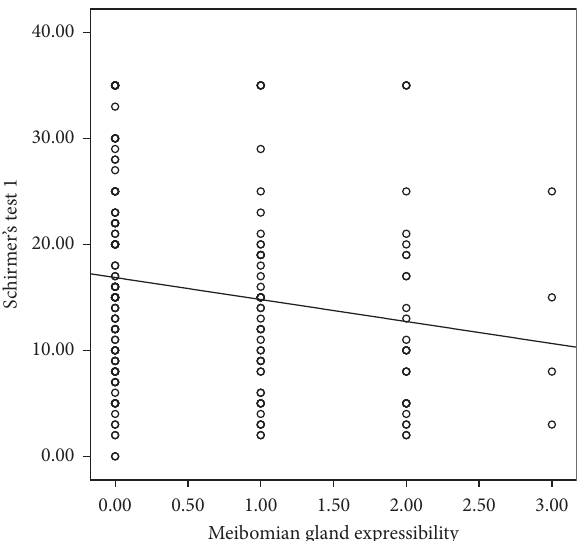
Figure 4: Correlation between Schirmer’s test 1 and ocular surface staining (oxford grading